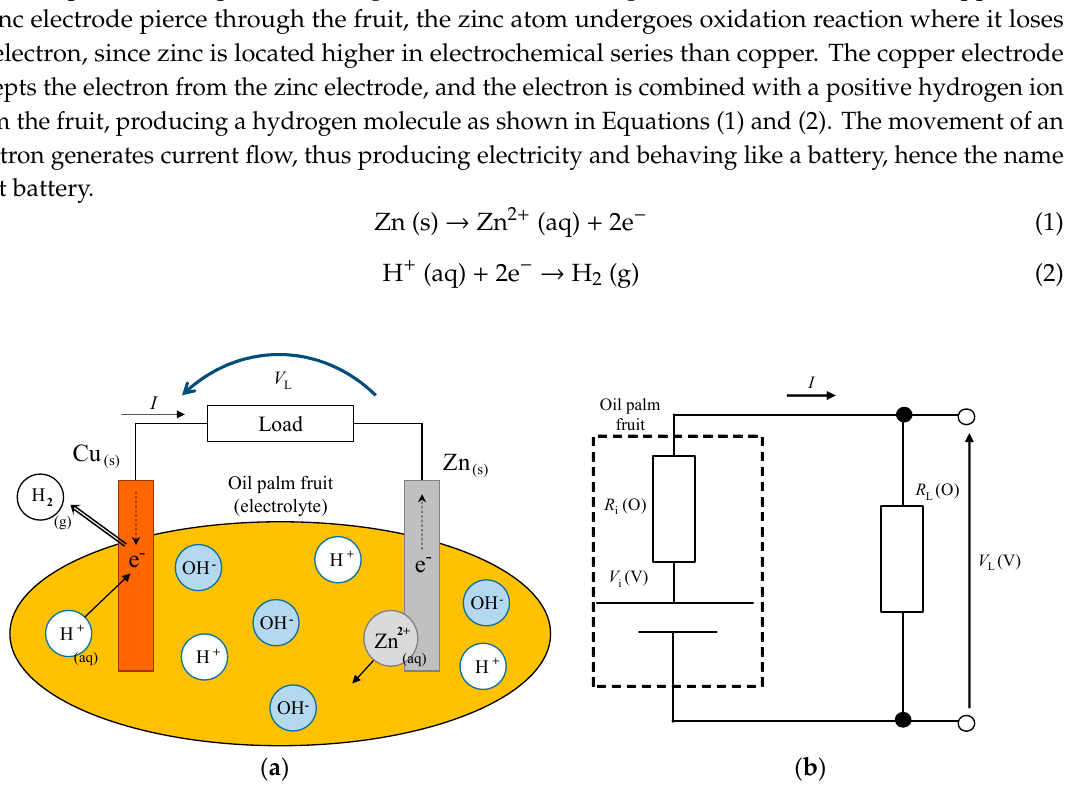
Figure 2. ( a ) Schematic diagram of the fruit battery and ( b ) simple equivalent circuit of the fruit battery.